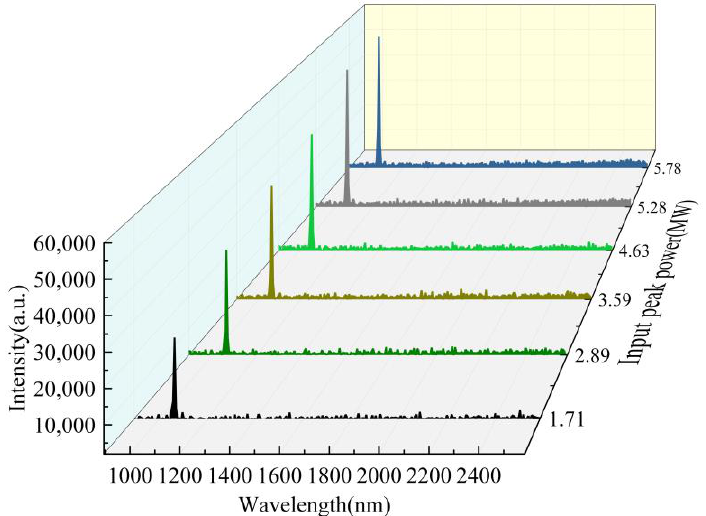
Figure 6. Measured output spectra under vacuumed (800 Pa) AR-HCF for different incident power.